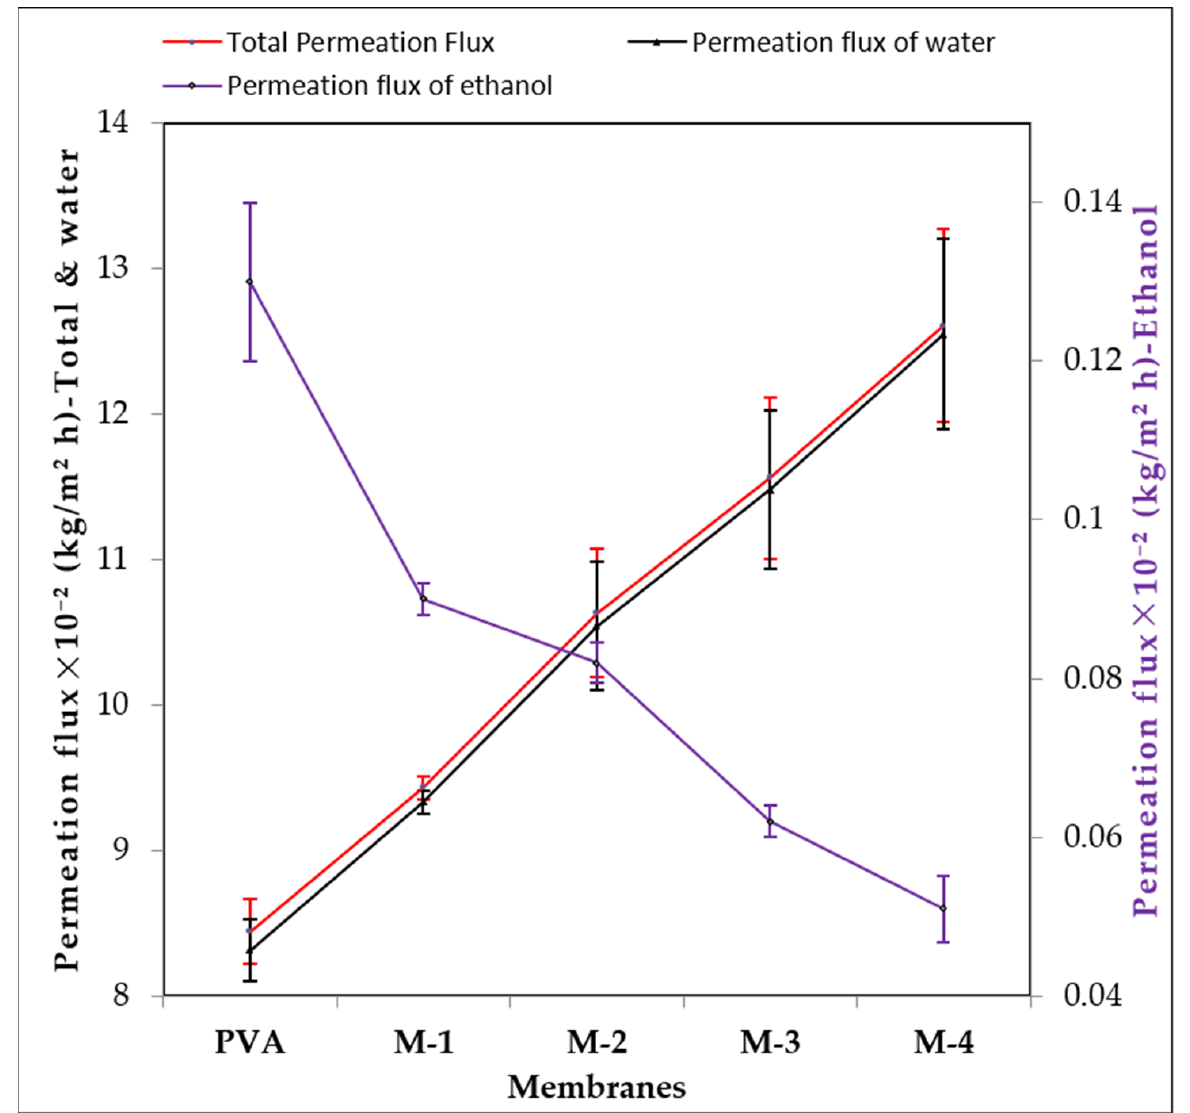
Figure 8. Deviation in total permeation flux and permeation fluxes of water and ethanol at 30 °C.